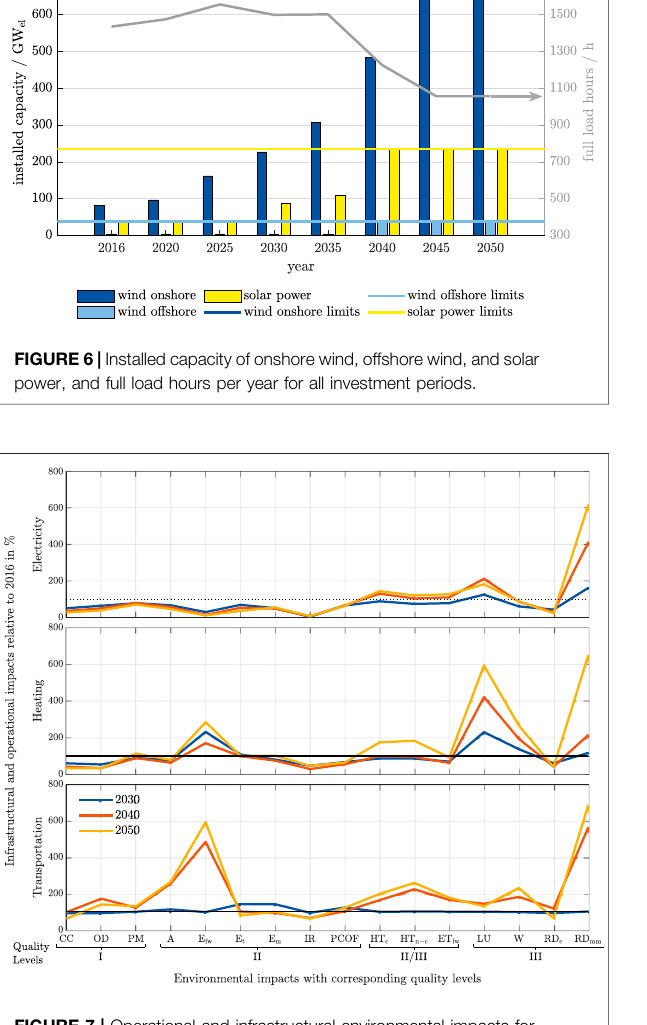
Frontiers in Energy Research |